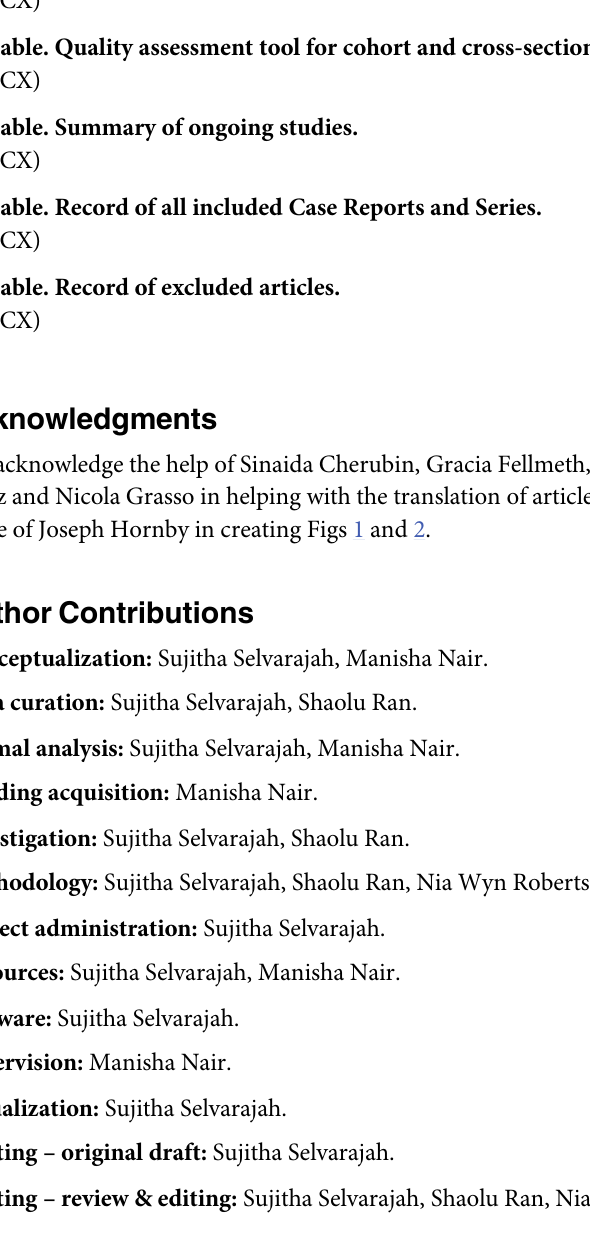
S2 Table. Quality assessment tool for cohort and cross-sectional studies. S3 Table. Summary of ongoing studies.